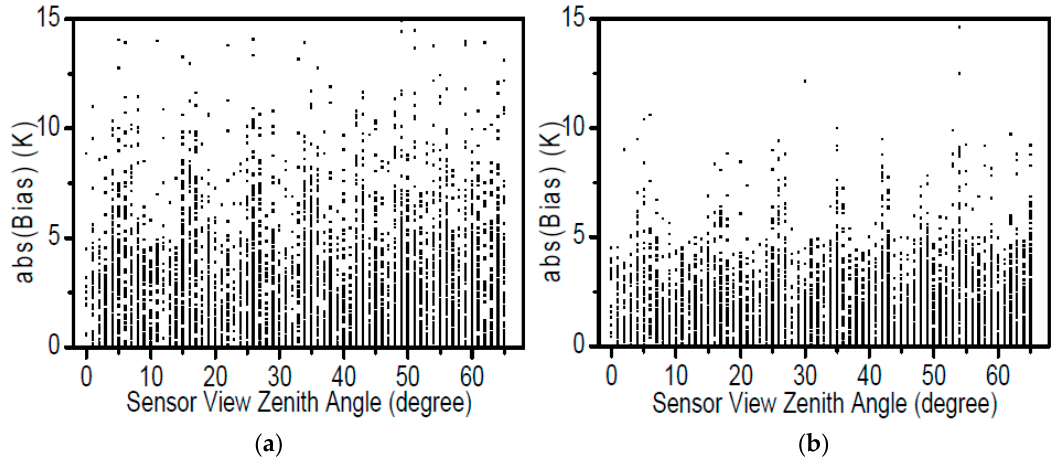
Figure 11. Relationships between the bias and zenith angle of MODIS when viewing the pixels: ( a ) relationship during the daytime; and ( b ) relationship at nighttime.